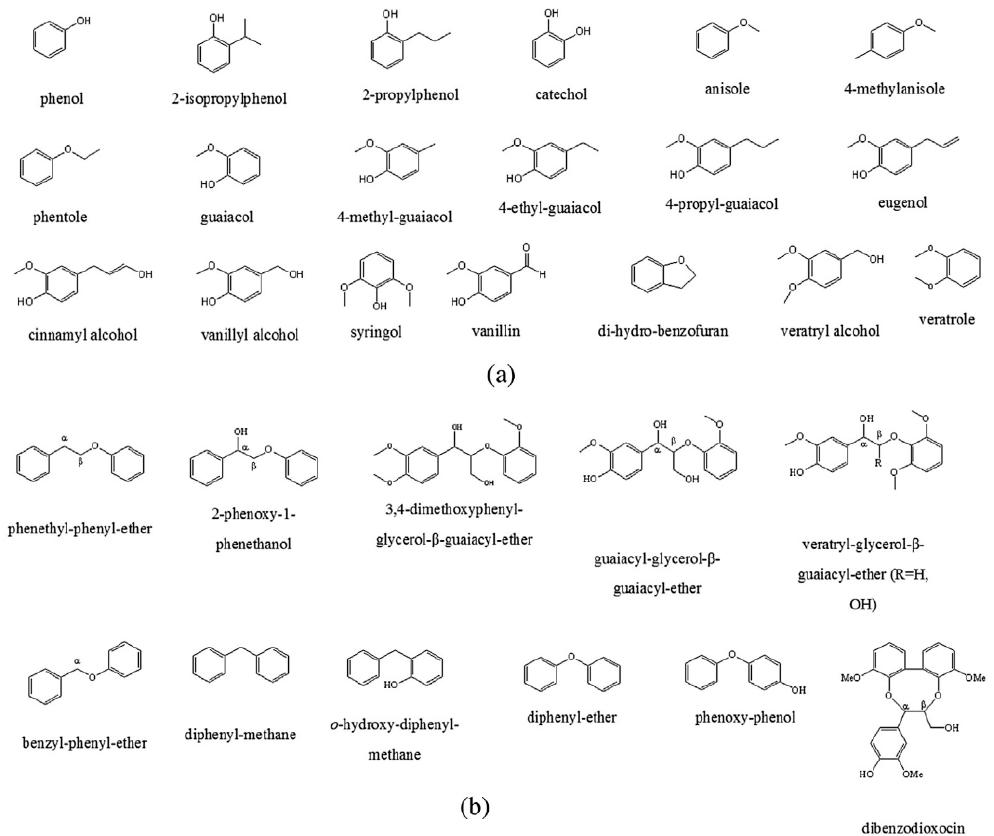
Figure 7. Lignin model compounds of monomers ( a ) and dimers ( b ) form ref [43] .